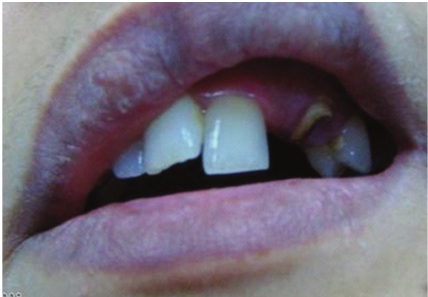
Figure 1: Frontal view of dentition of patient no. 1 with missing lateral incisor and endodontically treated canine.